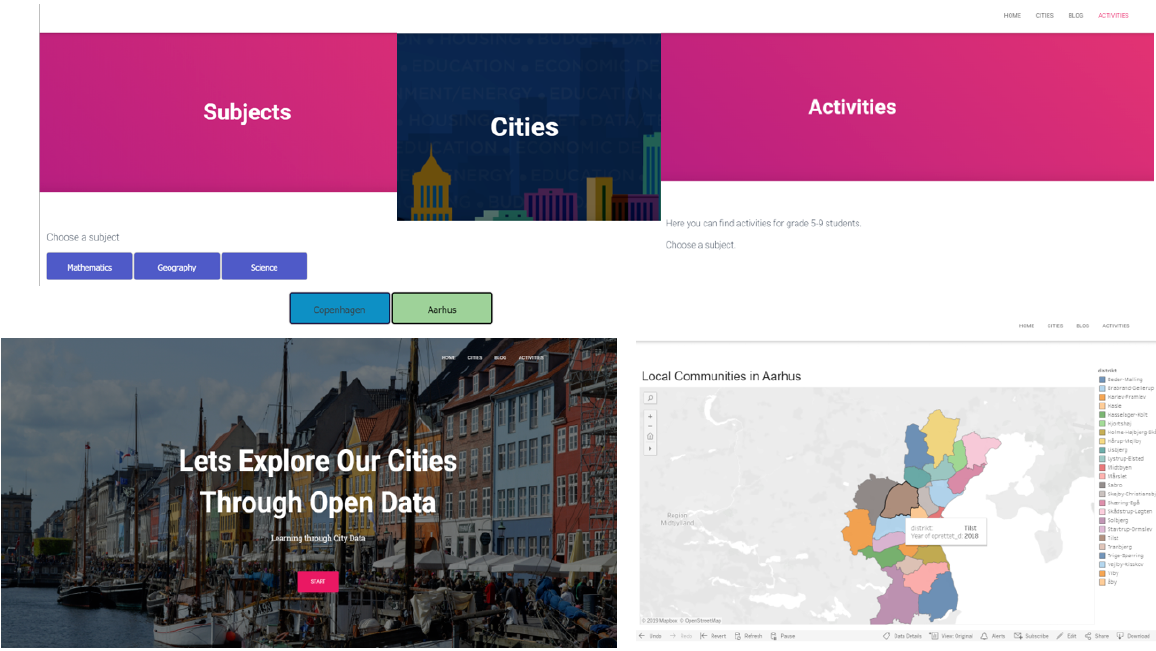
Figure 10. Open Data web